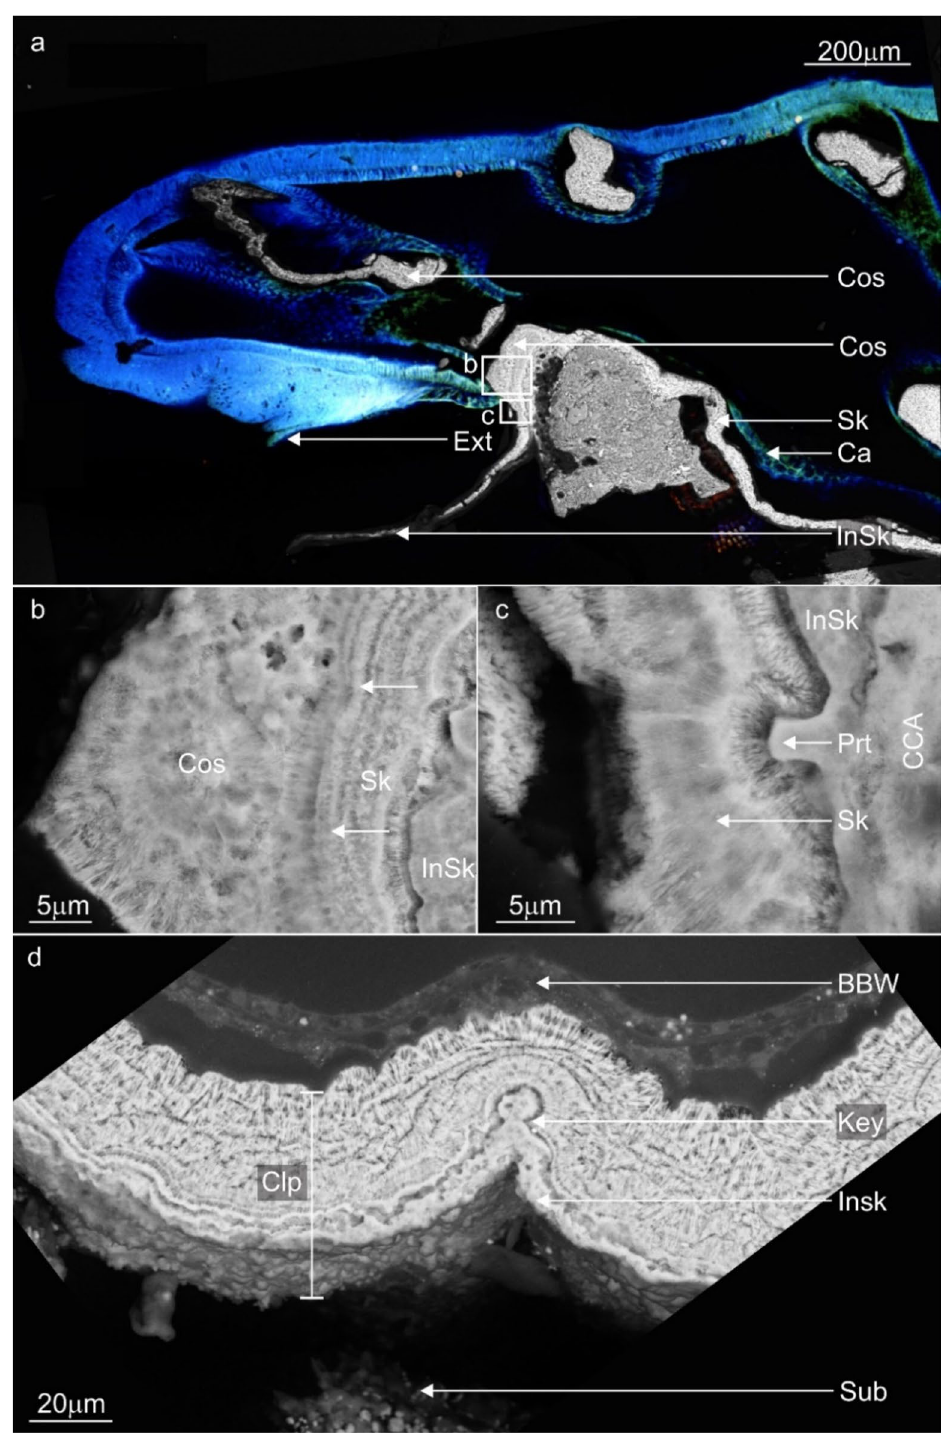
Figure 9. Representative confocal fluorescence microscopy images and backscatter electron microscopy images highlighting the costae wall and initial skeletal layer development in the lappet-like appendage. ( a ) A confocal fluorescence image of the lappet-like appendage overlayed with the corresponding SEM image showing the morphology of the lappet-like appendage and its relationship to the costae (Cos), initial basal deposits (InSk) and the basal skeleton (Sk). ( b , c ) First, the lappet-like appendage deposits an initial skeleton (InSk) via the lappet-like appendage poorly defined calicoblastic extension; then, as the lappet-like appendage moves forward, the trailing calicodermis produces a layer of skeleton (Sk) (arrows show the direction of the thickening), building a stronger basal attachment. The lappet-like appendage can generate rapid accretion deposits (RADs) ( b ) that form the costae walls (Cos) and further the robustness of the skeleton/attachment. ( c ) The lappet-like ’appendage’s poorly defined calicoblastic extending layer ( a ) (Ext) appears to produce a protuberance (Prt) in the initial skeleton (InSk). ( d ) The smooth initial skeleton layer possesses characteristics similar to those of Clypeotheca (Clp) and can form a keystone structure (Key) in a similar fashion to dissepiments, which can indicate irregular development 8 . CCA; crustose coralline algae, Sub; substrate. calicodermis; Ca, calicodermis extension; Ext, substrate;